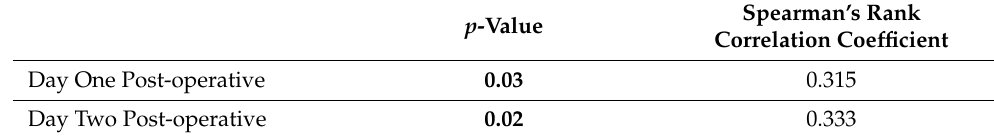
Spearman’s Rank p -Value Correlation Coefficient